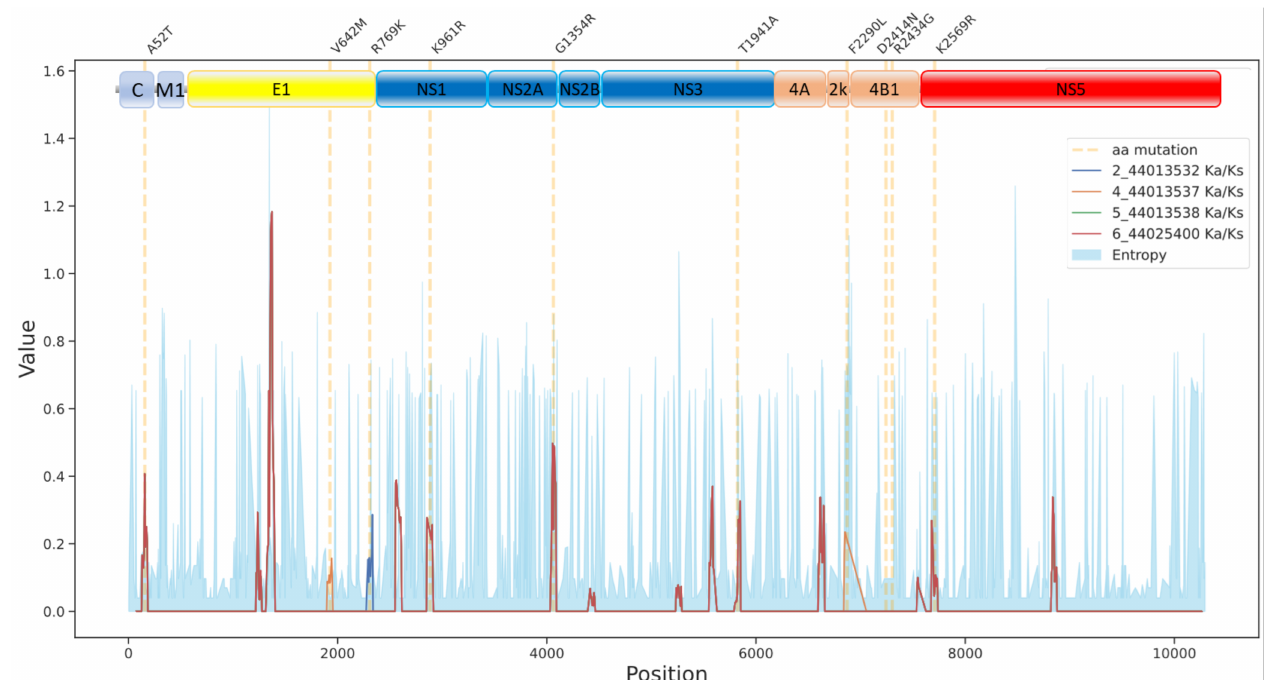
Figure 3. Mutational pattern observed in the Spanish outbreak with respect to its previous ancestor (branching point 1 in Figure 2) along the genome sequence. The entropy plot indicates the background variability observed in the genome of the 152 WNV sequences included in the